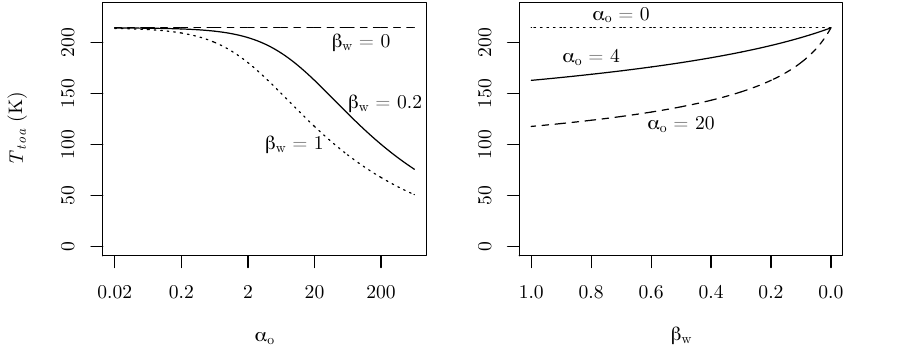
Figure 6. The dependence of the overall equilibrium temperature at the top of the atmosphere on the parameters α o and β w in the window- grey model (Eq. 32). β w = 0 corresponds to the grey case. T eff,eq =